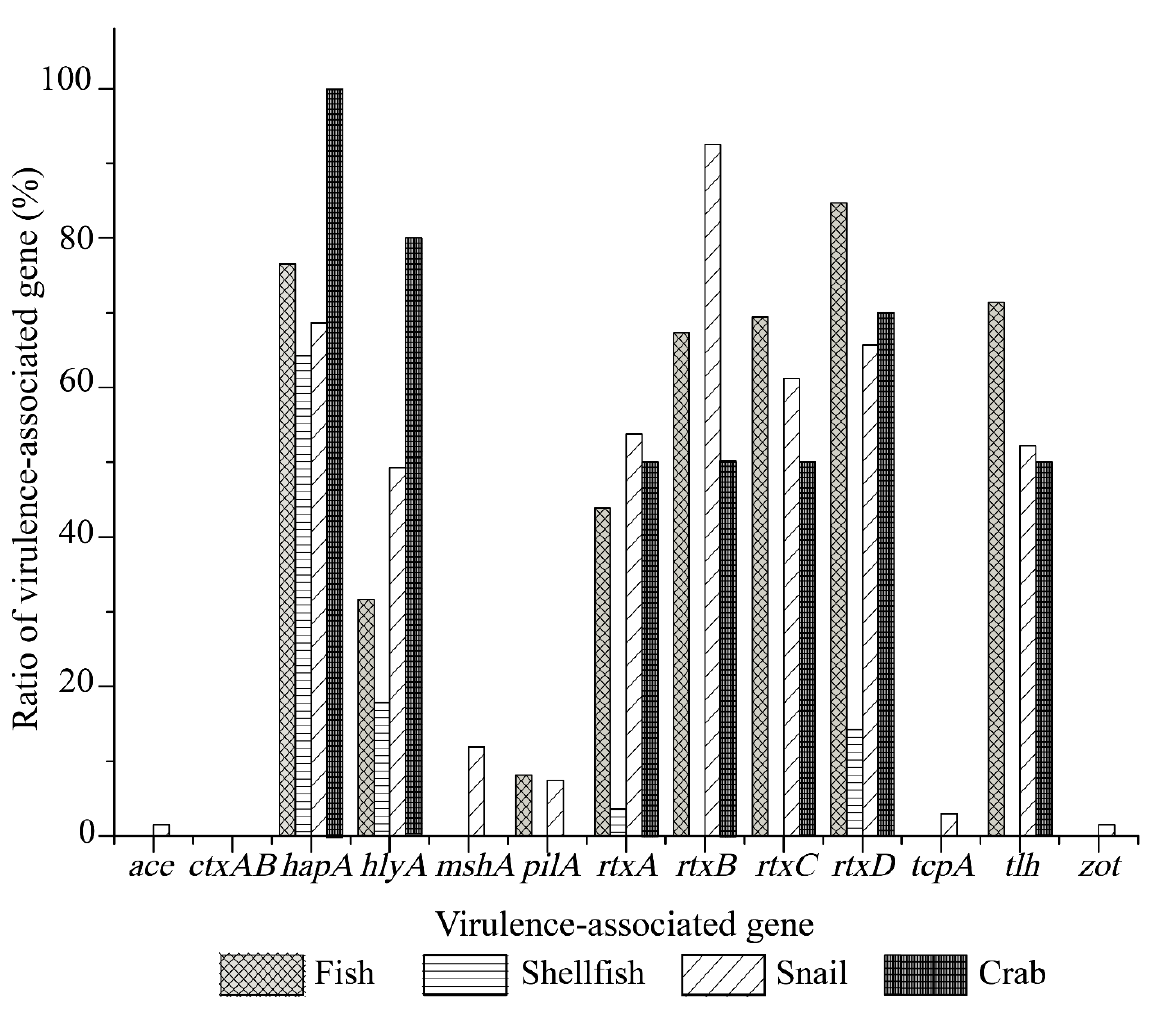
Figure 1. Virulence-associated gene profiles of the V. cholerae isolates recovered from the four types of aquatic food ani- mals.